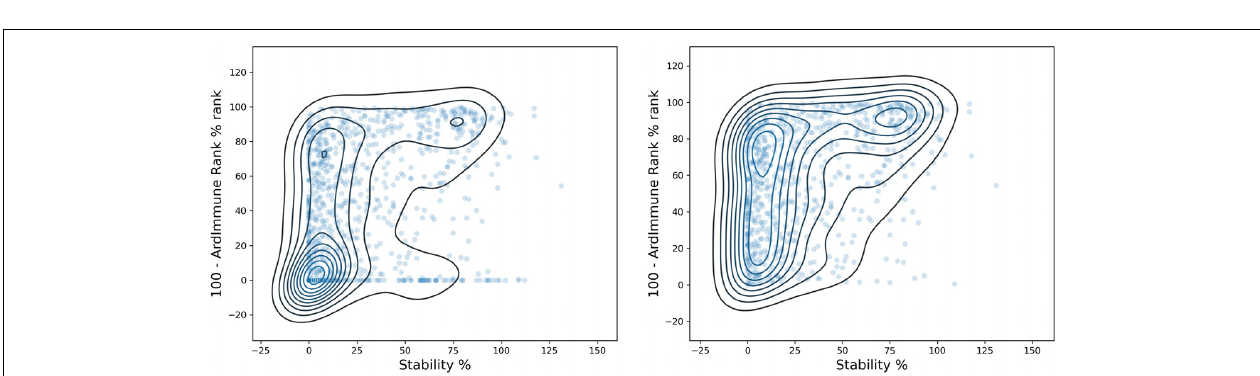
FIGURE 9 | Comparison between ArdImmune Rank percentile ranks for pHLA immunogenicity and pHLA stability data measured by Prachar et al. (2020) Scatter plots and kernel density estimations are shown with (right) and without (left) the exclusion of pHLA predicted non-binders (K d percentile rank ≥ 2). The complement of the ArdImmune Rank percentile rank is shown on the y-axis (higher value = lower rank), while the stability percentage as reported by Prachar et al. (2020) is shown on the x-axis.